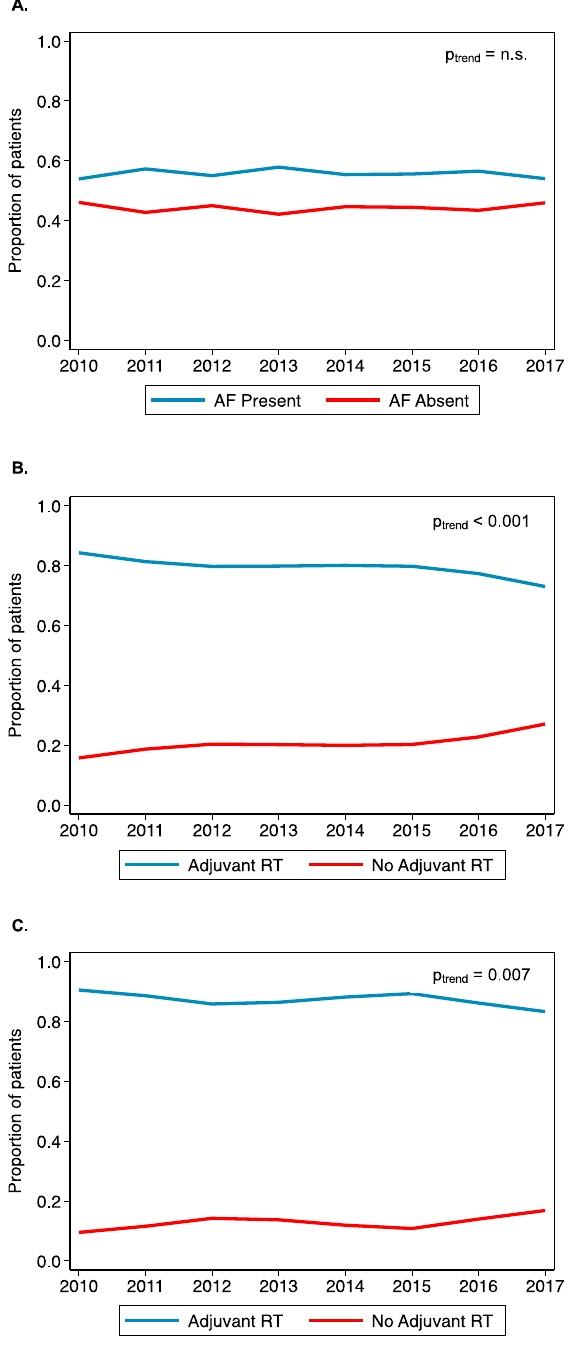
Figure 3. Trends in Adjuvant Radiotherapy and Adverse Features in HPV ‐ OPC ( A ) Trends in HPV ‐ OPC with Adverse Features ( B ) Trends in HPV ‐ OPC receiving Adjuvant RT ( C ) Trends in AF ‐ HPV ‐ OPC receiving Adjuvant RT.